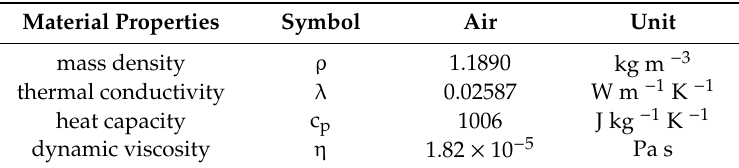
Figure 6. Normalized thermophysical properties of aluminium alloy (EN AW-6181) ( a ) and steel (1.0034) ( b ).